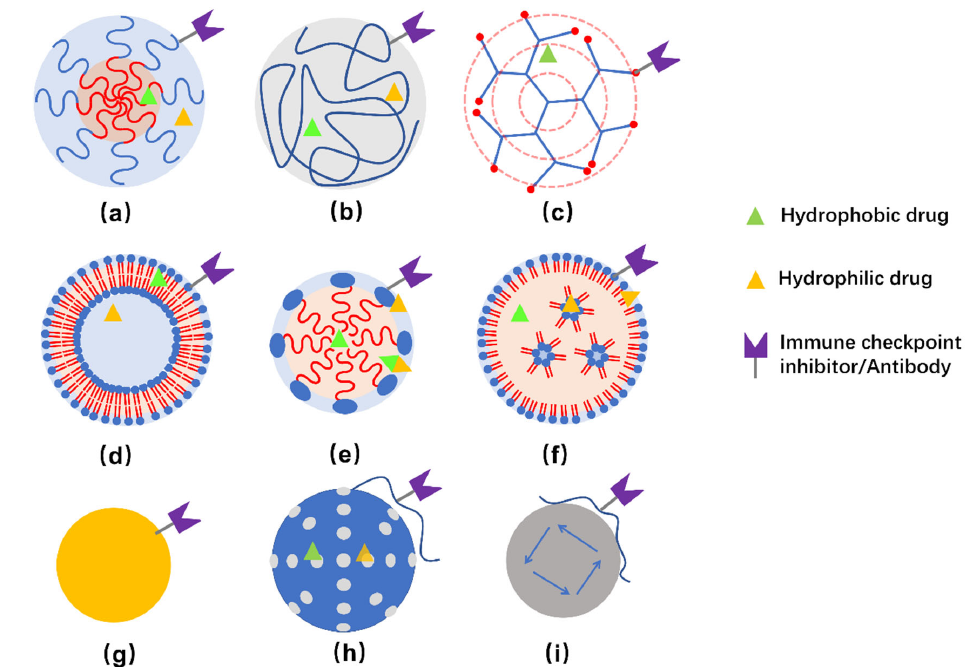
Figure 2. Schemes of structure of polymeric nanocarriers ( a – c ), lipid-based nanocarriers ( d – e ), and inorganic NPs ( g – i ). ( a ) polymeric micelle, ( b ) polymeric NP, ( c ) dendrimer, ( d ) liposome, ( e ) lipid emulsion, ( f ) lipid NPs, ( g ) Au ‐ NPs, ( h ) silica NPs, and ( i ) magnetic NPs. Hydrophobic, hydrophilic, as well as amphiphilic drugs can be embedded in corresponding regions. Meanwhile, it is possible to conjugate immune checkpoint inhibitors and/or antibodies to the surface of nanocarriers for therapeutic and/or targeting purposes. Usually, hybrid NPs are developed to obtain multiple function or improved properties for delivering the drugs.